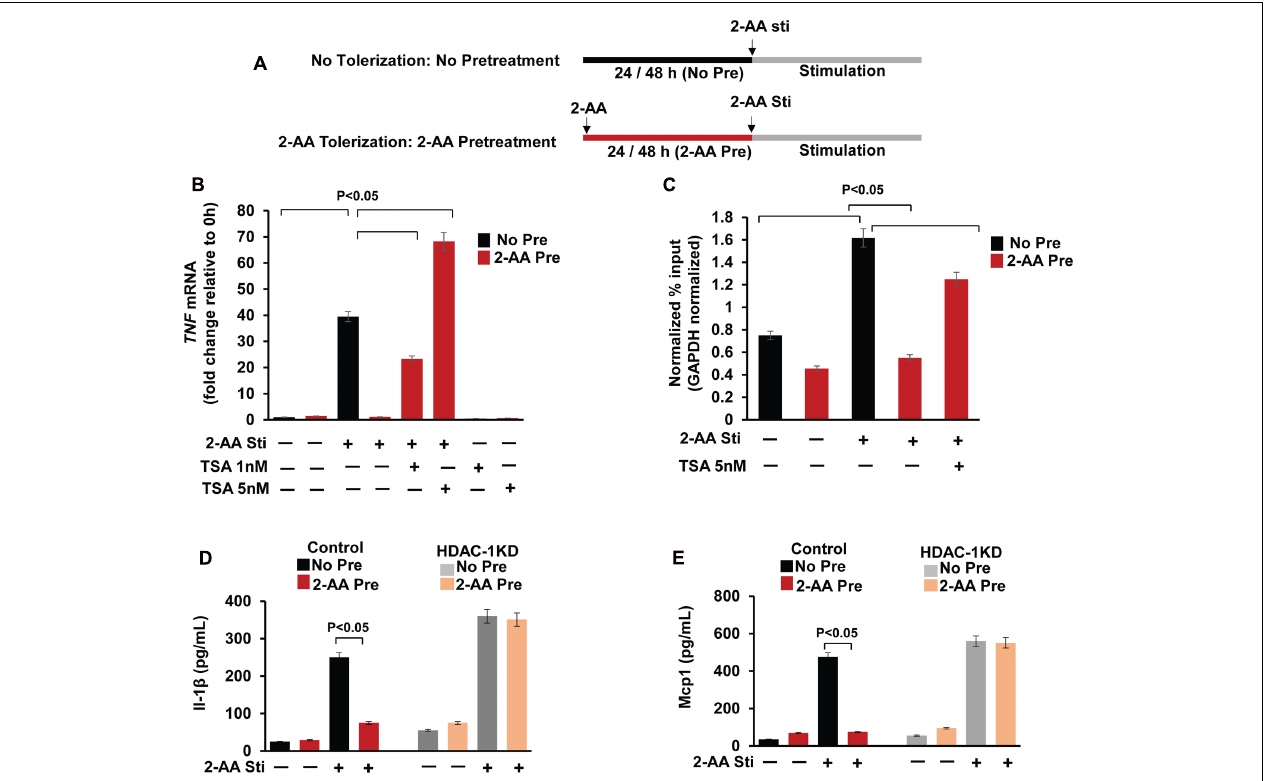
FIGURE 2 | Pharmacological and genetic inhibition of HDAC1 rescue the 2-AA-mediated immunomodulation. (A) Schematic representation of the 2-AA treatments. The human monocytes THP-1 cells and mouse macrophage RAW264.7 cell cells were left untreated (No Pre: No Tolerization) or pretreated with 2-AA for 24 h or 48 h (2-AA Pre: 2-AA tolerization) respectively, and then stimulated (Sti) with 2-AA. (B) Expression of TNF (1 h) was measured in non-pretreated, 2-AA pretreated and 2-AA + TSA pretreated THP-1 cells following 2-AA stimulation. Transcript levels were assessed by qRT-PCR and normalized to GAPDH . (C) ChIP assay of H3K18ac at the TNF promoter of 2-AA-pretreated, 2-AA and TSA pretreated or non-pretreated THP-1 cells following 3 h 2-AA stimulation, assessed by qRT-PCR with primer covering the promoter site region of TNF relative to GAPDH. (D,E) ELISA of IL-1 β and Mcp1 secretion in culture supernatant of 2-AA pretreated vector control RAW264.7 and HDAC1 KD cells following 6 h 2-AA stimulation ( n = 3; means ± SDs; p < 0.05, Student’s t